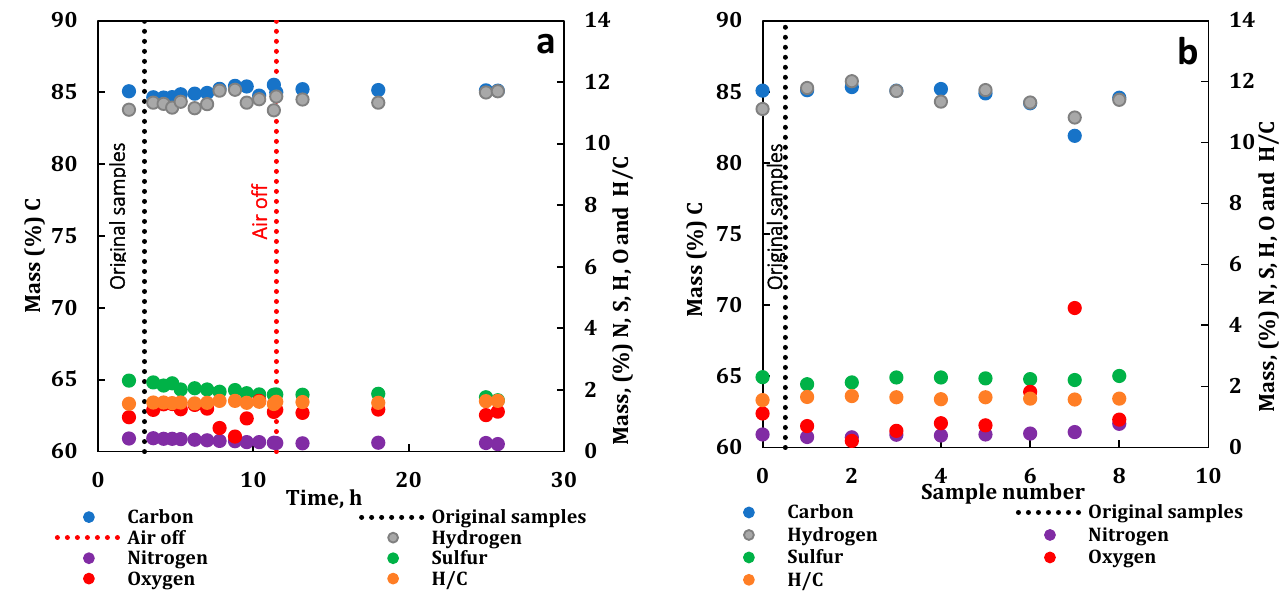
Figure 20. Samples of ( a ) produced oil and ( b ) extracted residual from the core samples.